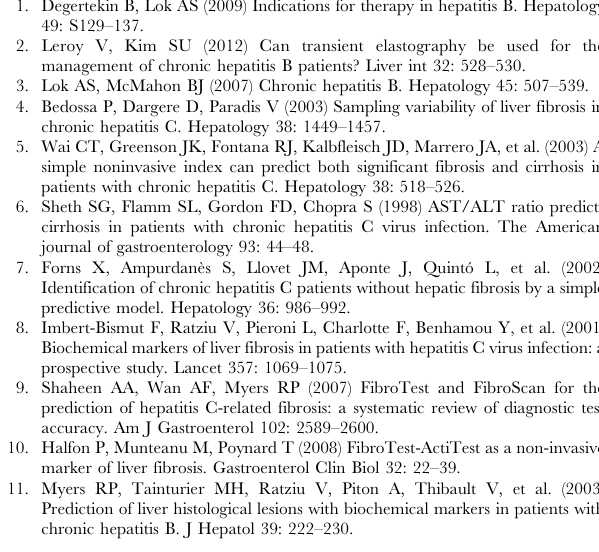
Table S1 Diagnostic performance (AUROC) of each compo- nent for FT and ELF. Table S2 Distribution and agreement of fibrosis stages accord- ing to histology and ELF (n=